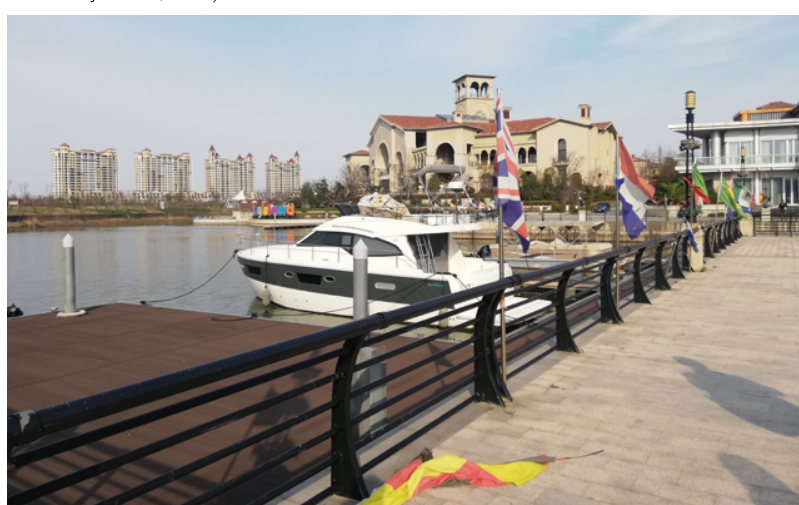
Empty real estate for investment on Long Island. According to real estate agents and spoken residents almost 100% of the units are owned by Shanghainese (photo by author, 2019).